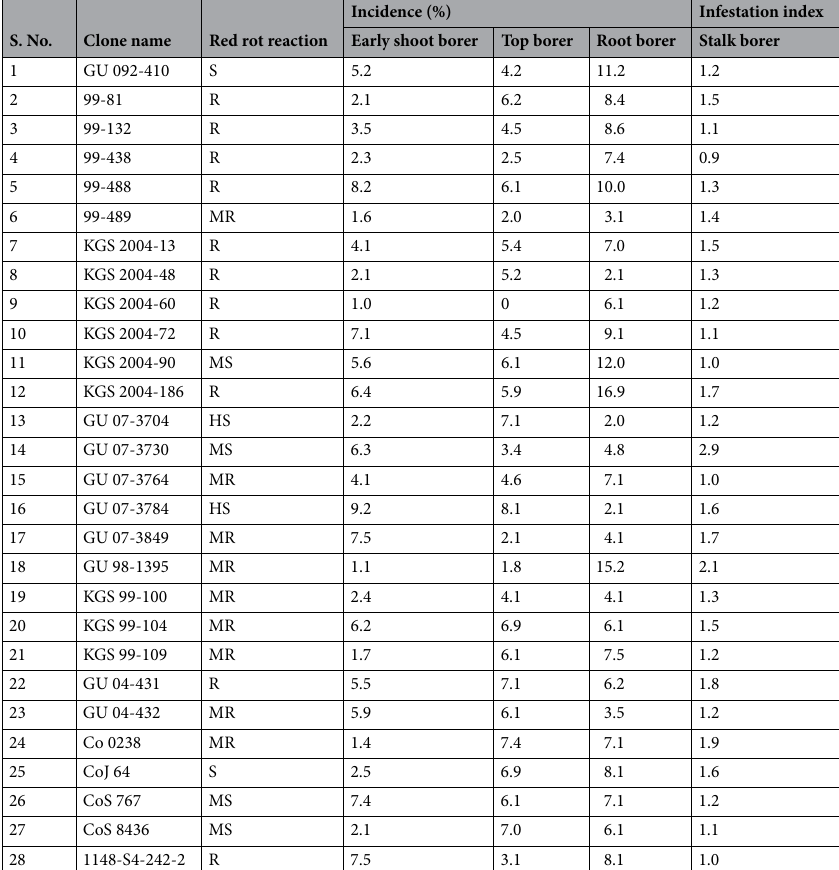
Table 4. Evaluation of ISH/IGH clones for red rot and